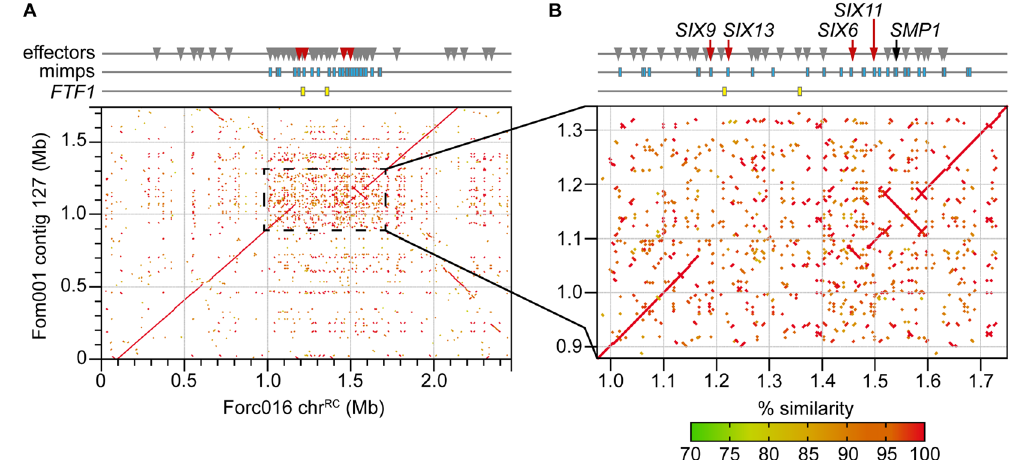
Figure 3. Comparison of chr RC with Fom001 contig 127 reveals a highly dynamic central region containing the majority of the miniature impala (mimp) TEs and candidate effector genes of the Forc genome. ( A ) The chromosomes of the Fom and Forc strains are mostly syntenic, with large stretches showing 100% identity in this nucmer alignment. ( B ) The dynamic central region of the chromosome, about 700 kb in size, has the highest repeat density, 30 of the 35 mimps of the Forc genome and the majority of the Forc candidate effector genes, including SIX9 , 13 , 6 and 11 and SMP1 . Additionally, the two FTF1 homologs present in the Forc genome are found